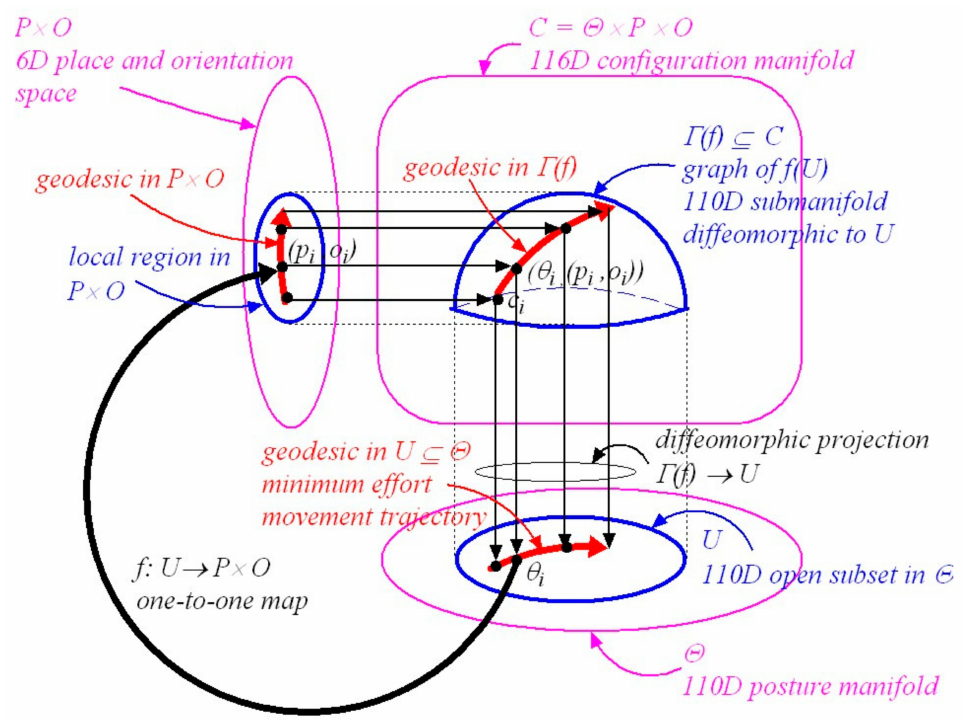
Figure 1. A schematic diagram illustrating the Riemannian theory of graphs of submanifolds . Θ designates the smooth 110D posture manifold spanned by the 110 elemental movements of the body. P × O designates the smooth 6D place-and-orientation manifold spanning the place and orientation space of the head in the 3D environment. U designates a neighbourhood in the posture manifold Θ about a given initial posture θ i ∈ Θ where there exists a fixed mapping f : U → P × O between the open subset U ⊆ Θ in posture space and the position and orientation of the head in a local region of P × O . The graph of the map f : U → P × O is designated by Γ ( f ) . Γ ( f ) is a 110D submanifold embedded in the configuration manifold C = Θ × P × O that is diffeomorphic to the 110D open subset U ⊆ Θ in the posture manifold Θ . Different mappings f between posture and the place and orientation of the head are represented by different submanifolds Γ ( f )